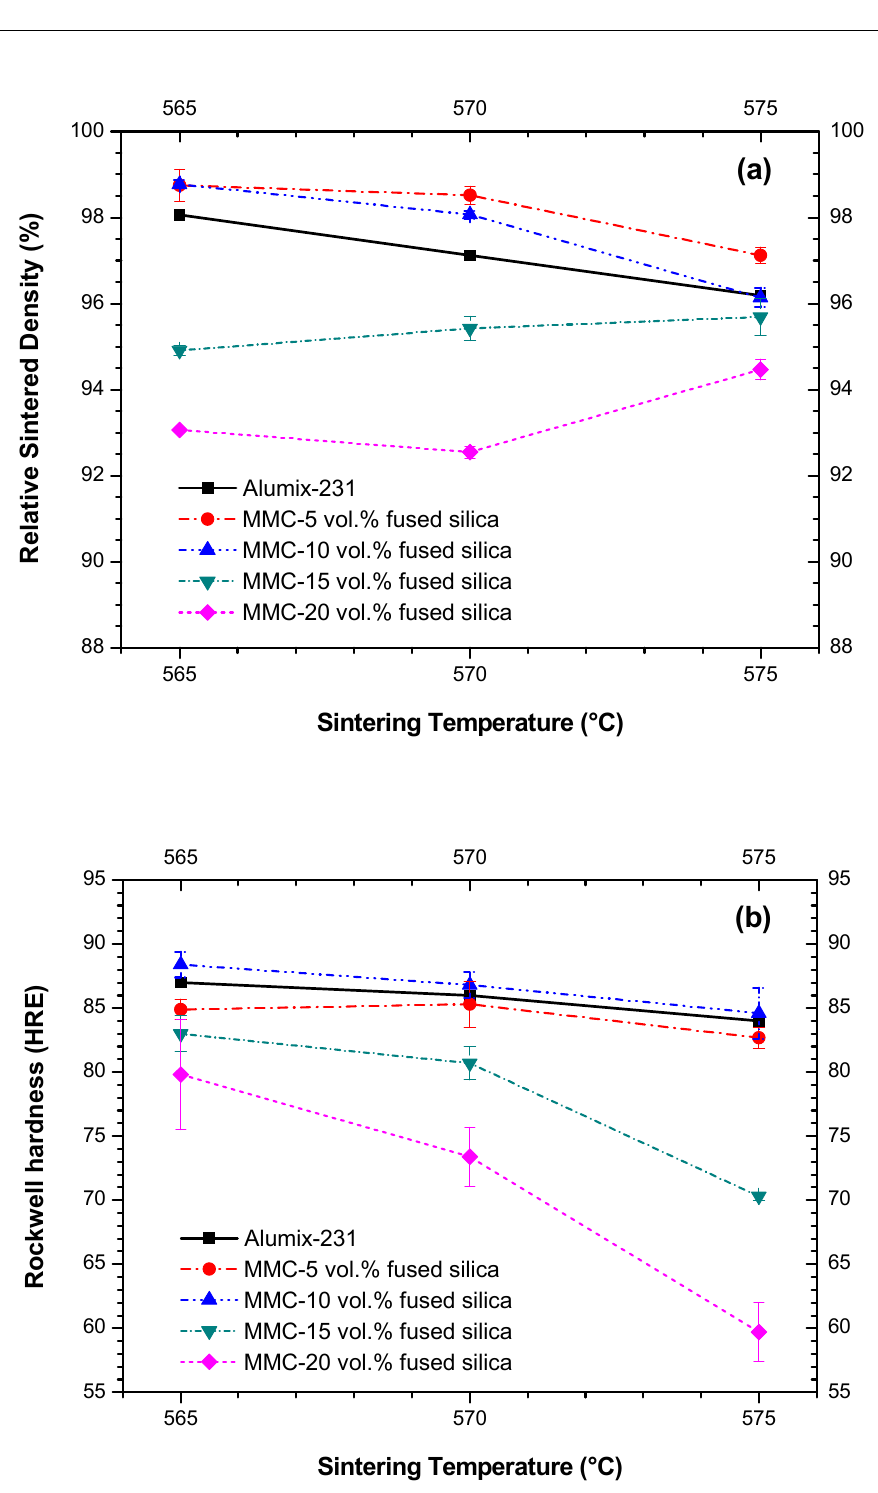
Figure 9. Variation of density and hardness of MMCs, in respect to sintering temperature, ( a ) relative sintered density, and ( b ) Rockwell hardness, versus sintering temperatures. Densities and hardness of neat Alumix-231 sintered at 565, 570, and 575 ◦ C and measured in our samples were essentially the same as those measured by Heard et al. [12].